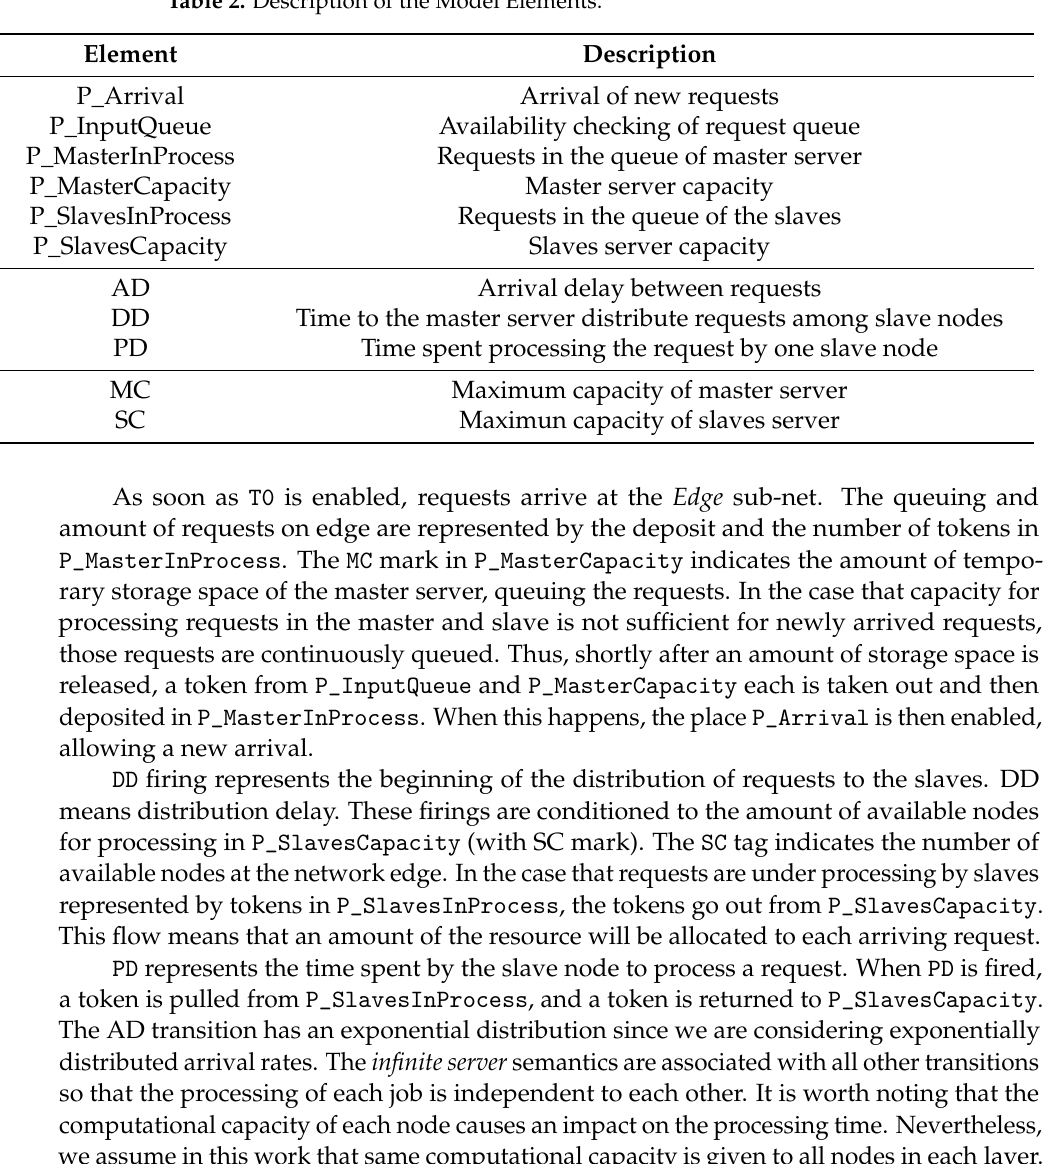
Table 2. Description of the Model